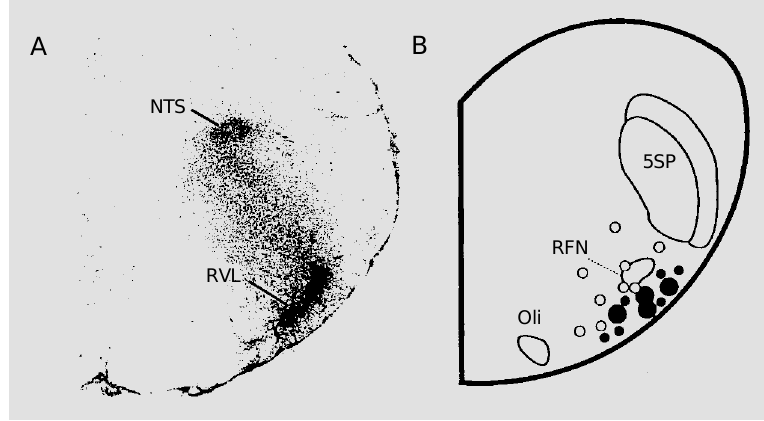
Figure 1 - A , Distribution of Ang II receptor binding sites in the rostral VLM (RVL) of the rabbit, using in vitro autoradiography (adapted from Ref. 3 and reprinted with the kind permission of the publisher). B , Distribution of sites in the rostral VLM of the rabbit at which microinjections of Ang II (20 pmol in 20 nl) elicited rises in mean arterial pressure of 6-20 mmHg (small filled circles) or more than 20 mmHg (large filled circles). The open circles indicate sites at which no significant change in mean arterial pressure was observed. (Adapted from Ref. 13, with the kind permission of the publisher). Note the close match between the receptor binding sites and the pressor sites. NTS, Nucleus tractus solitarius; RFN, retrofacial nucleus; 5SP, spinal trigeminal nucleus; Oli, inferior olivary